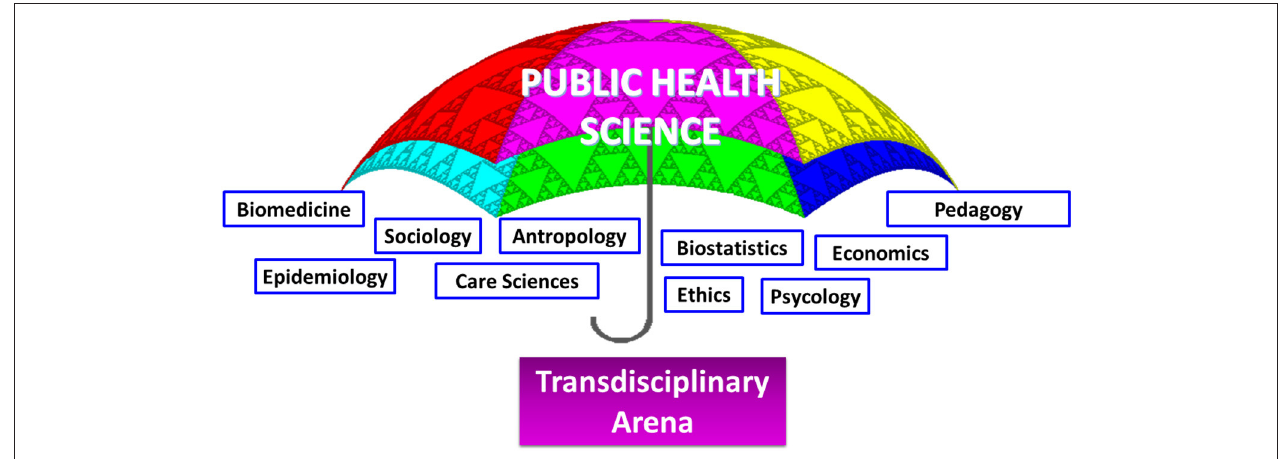
FIGURE 1 | Public Health Science can be seen as a health umbrella with several scientific areas feeding relevant parts of their knowledge and methodological tools into the discipline, thereby contributing to a transdisciplinary arena.